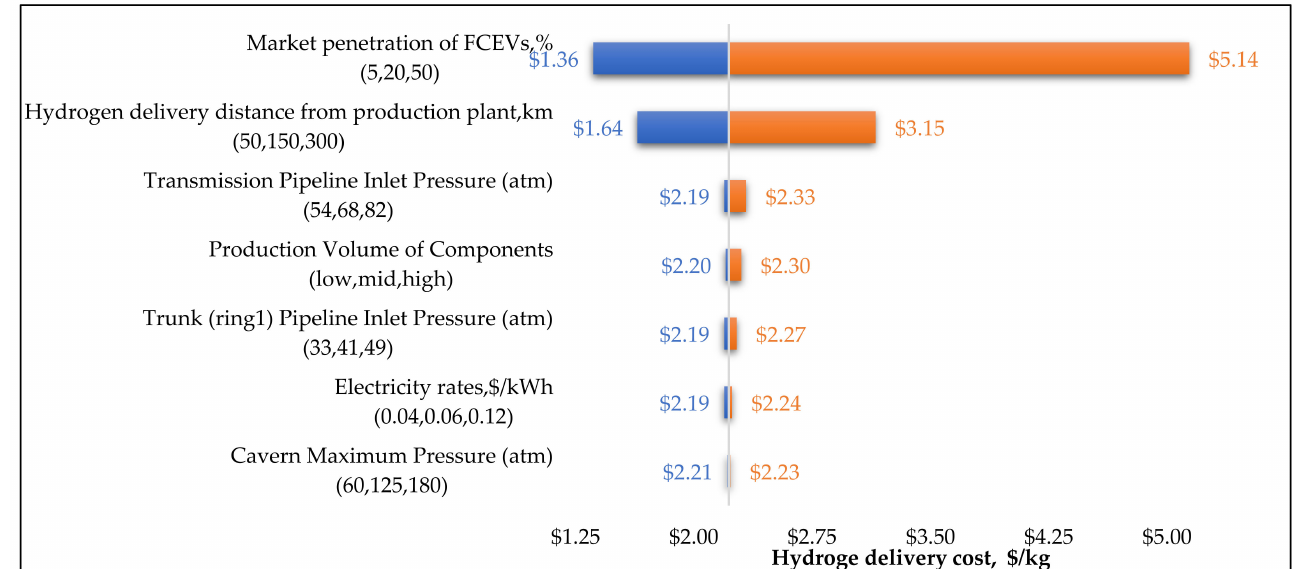
Figure 12. Range of pipeline delivery costs to a 1.5 tpd refueling